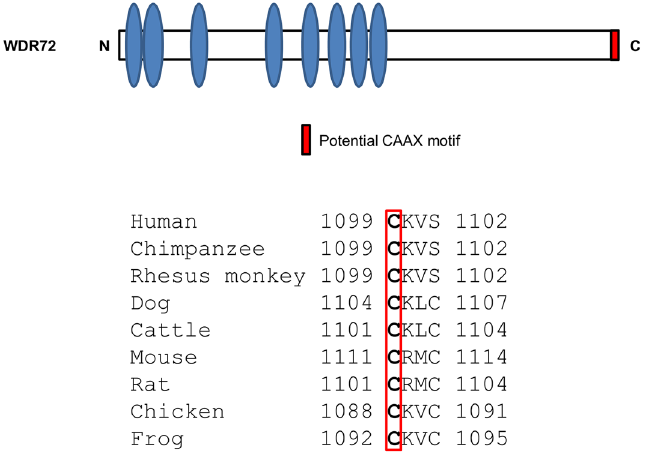
Figure 7. Potential CAAX motif is evolutionarily conserved among species. Schematic presentation of WDR72 protein domain structure (upper illustration). Each domain is symbolized such as WD 40 repeat and potential CAAX motif. The multiple sequence alignment of the last four amino acids containing potential CAAX motif (lower illustration). Protein accession number of WDR72 protein for each organism is as follows: human; NP_877435.3, chimpanzee; XP_003314726.1, rhesus monkey; XP_001088410.1, dog; XP_005638485.1, cattle; XP_002690944.1, mouse; NP_001028672.2, rat; NP_001129191.1, chicken; XP_004943846.1, frog;